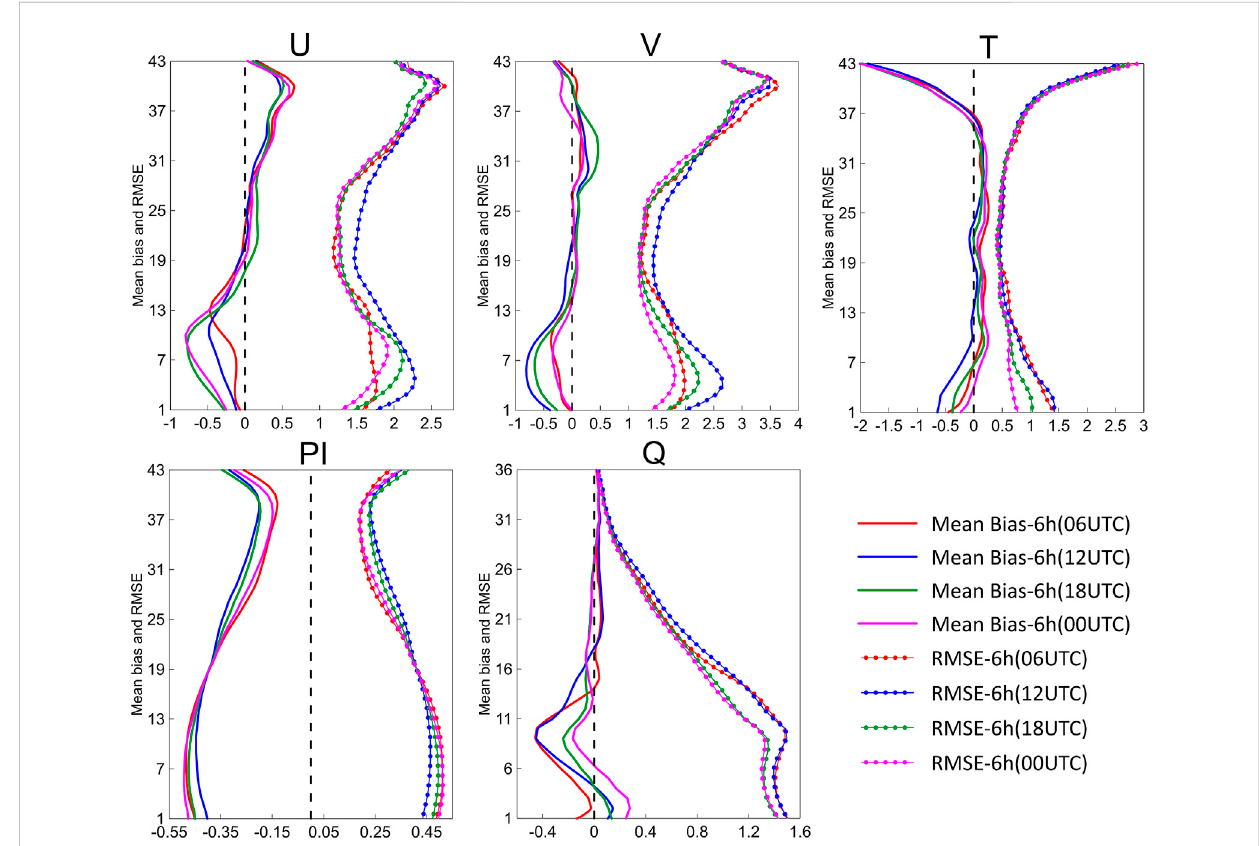
The vertical pro fi les of the horizontal mean bias and RMSE from June 1 to 15, 2022 (Pi and Q are multiplied by